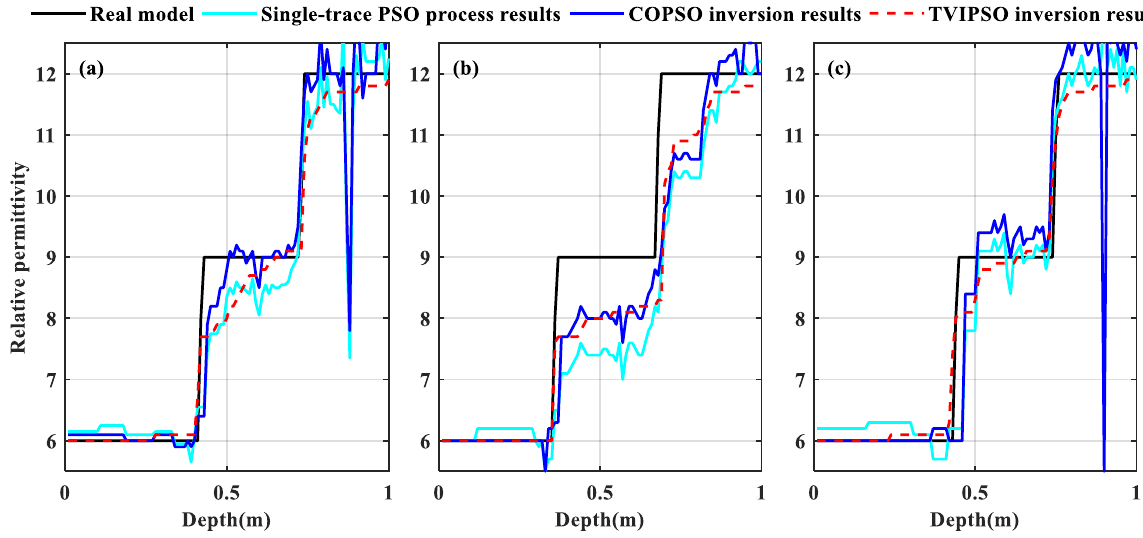
Figure 10. Comparison of dielectric permittivity inversion results: ( a ) at a distance of 0.16m, ( b ) the distance of 0.56m, and ( c ) the distance of 0.94m.